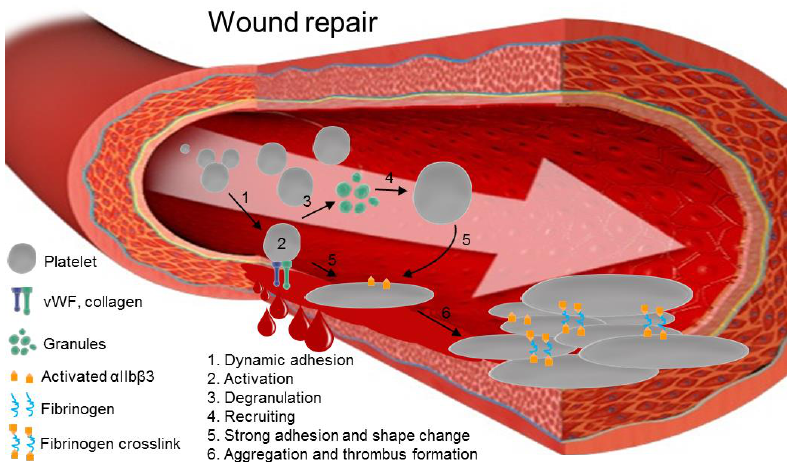
Figure 1. The steps in platelet activation and aggregation in thrombus formation after wounding. Damage to the epithelial wall of a vein exposes vWF and collagen. Receptors on platelets, such as glycoprotein Ib-IX (GP-Ib-IX), αIIbβ3, and glycoprotein VI (GPVI), reversibly bind to newly-exposed proteins ( 1 ). This induces internal signaling, leading to platelet activation ( 2 ). Platelets undergo degranulation ( 3 ) and secrete chemokines, including ADP, serotonin, ions like Ca 2+ , and other molecules that recruit additional platelets ( 4 ). Once activated platelets are bound on the endothelial wall, they progressively and definitively stick on the vein, changing their shape ( 5 ). Activated platelets form crosslinks via fibrinogen bridges between αIIbβ3 proteins, forming the thrombus ( 6 ). Oxidative stress is one possible cause of the functional changes in platelets that are observed in vitro after PIT treatment [19,20]. Indeed, amotosalen and riboflavin, which are the photosensitizers in INTERCEPT™ and Mirasol ® , respectively, can sensitize oxygen molecules via type I or II mechanisms following excitation by UV light and thereby generate reactive oxygen species (ROS), like 1 O 2 , O 2−· , H 2 O 2 , and OH [21,22]. Furthermore, UV light alone can induce the formation of ROS